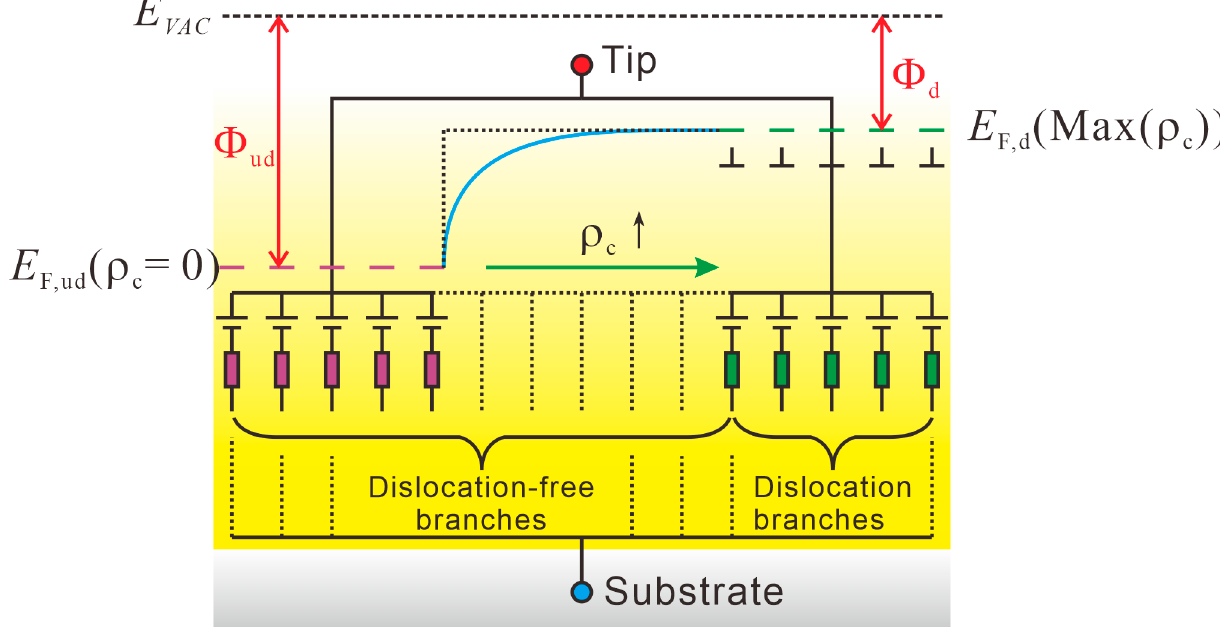
Figure 10. The schematic diagram of energy band concerning the relationship between Fermi levels and the dislocation density, E f,ud ( ρ c = 0) stand for the Fermi level of undeformed grains, E f,d (Max ( ρ c )) stand for the Fermi level of deformed grains, ( Φ d ) stand for Work function of deformed grains ( Φ ud ) stand for work function of undeformed grains, ρ c stand for the dislocation density.